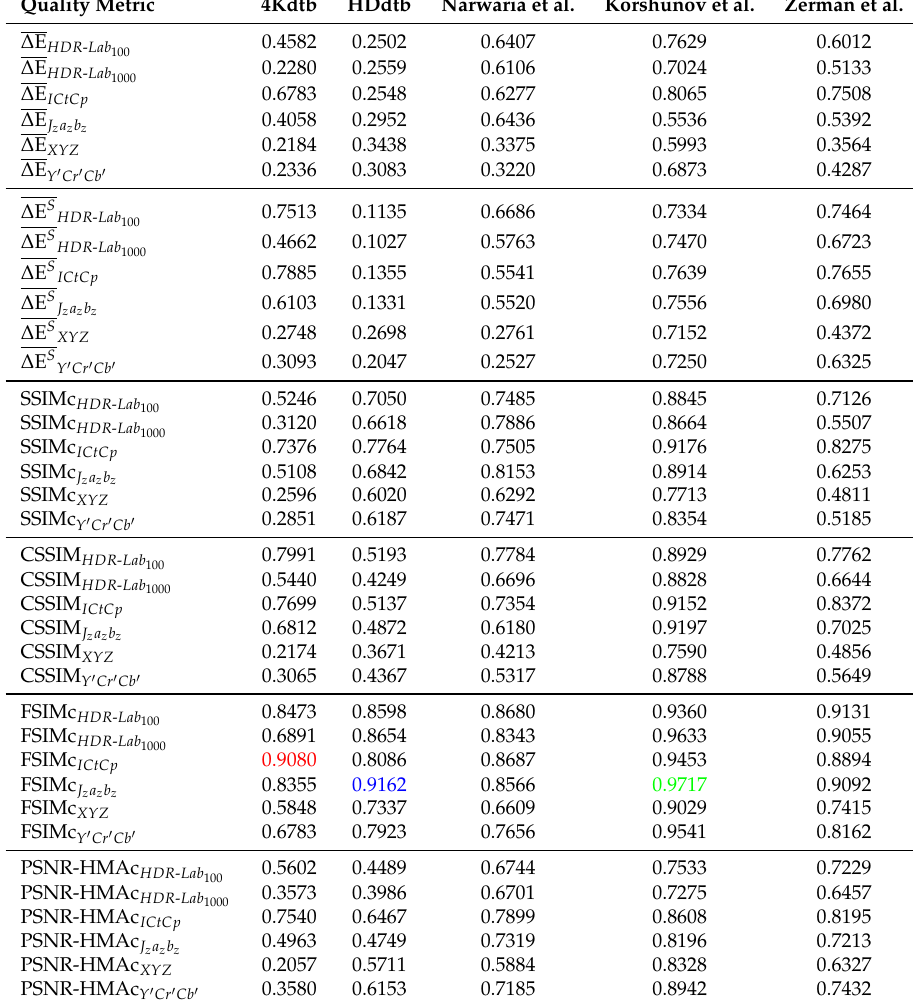
Table A2. PCC of the different color quality metrics on the considered